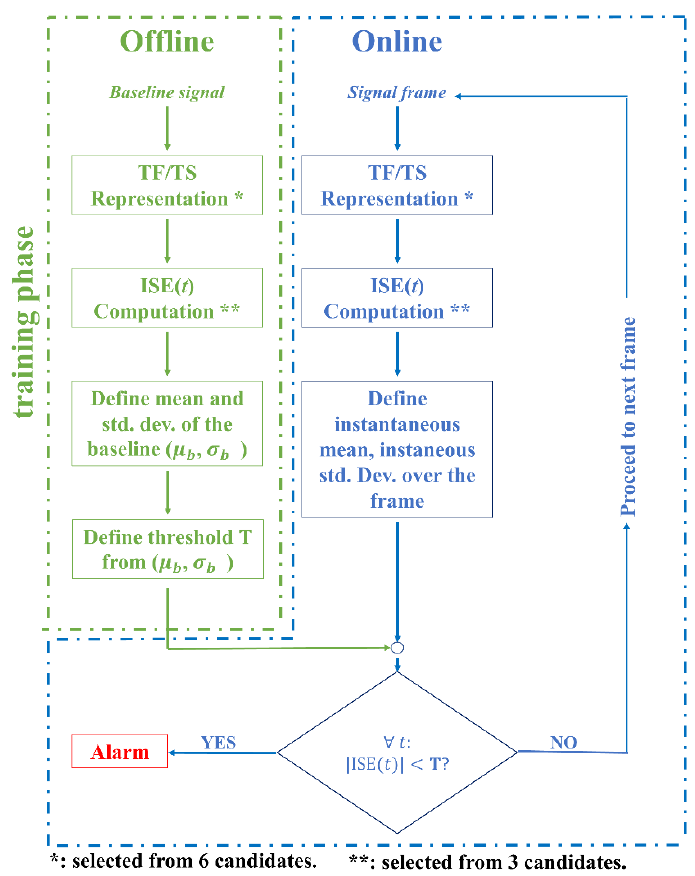
Figure 1. The complete flowchart of the proposed methodology.